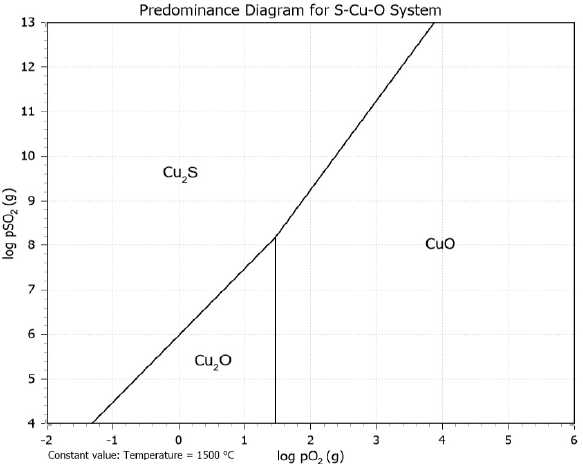
Figure 11. Cu-O-S stability diagram at 1500 °C constructed with HSC ® software.